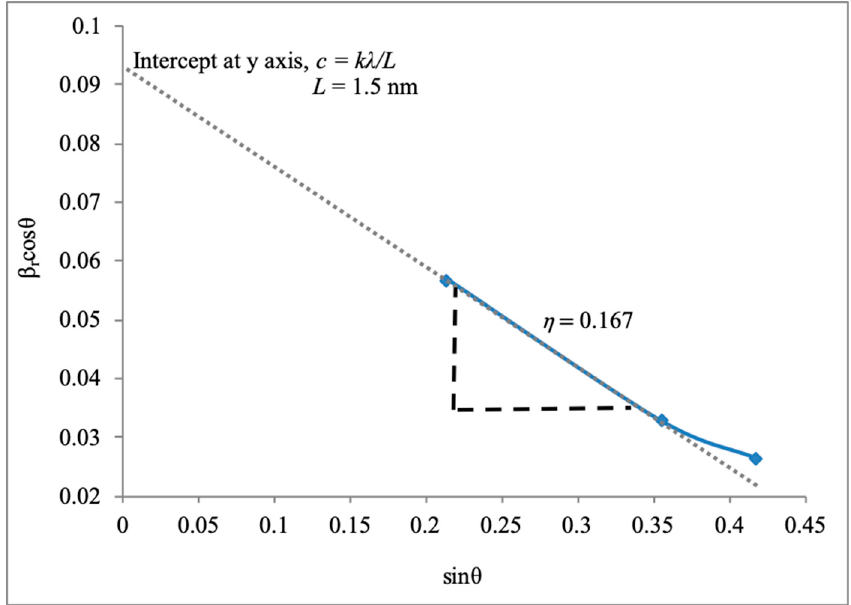
Processes 2018 , 6 , x FOR PEER REVIEW Figure 4. Plot of β r cos θ versus sin θ from XRD data of the 0 min sample. Figure 4. Plot of β r cos θ versus sin θ from XRD data of the 0 min sample.